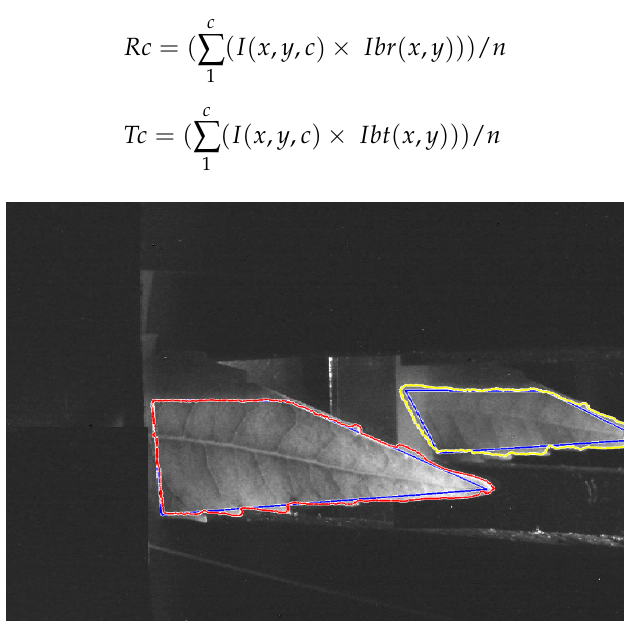
Figure 4. Leaf and background, separation process.